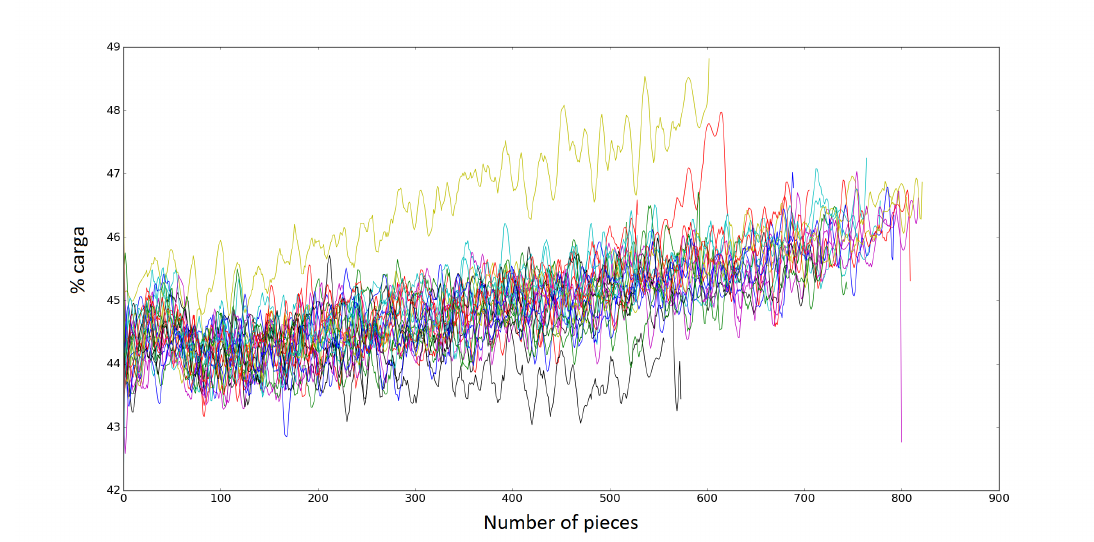
Figure 4. Time series after smoothing transformation in a period of